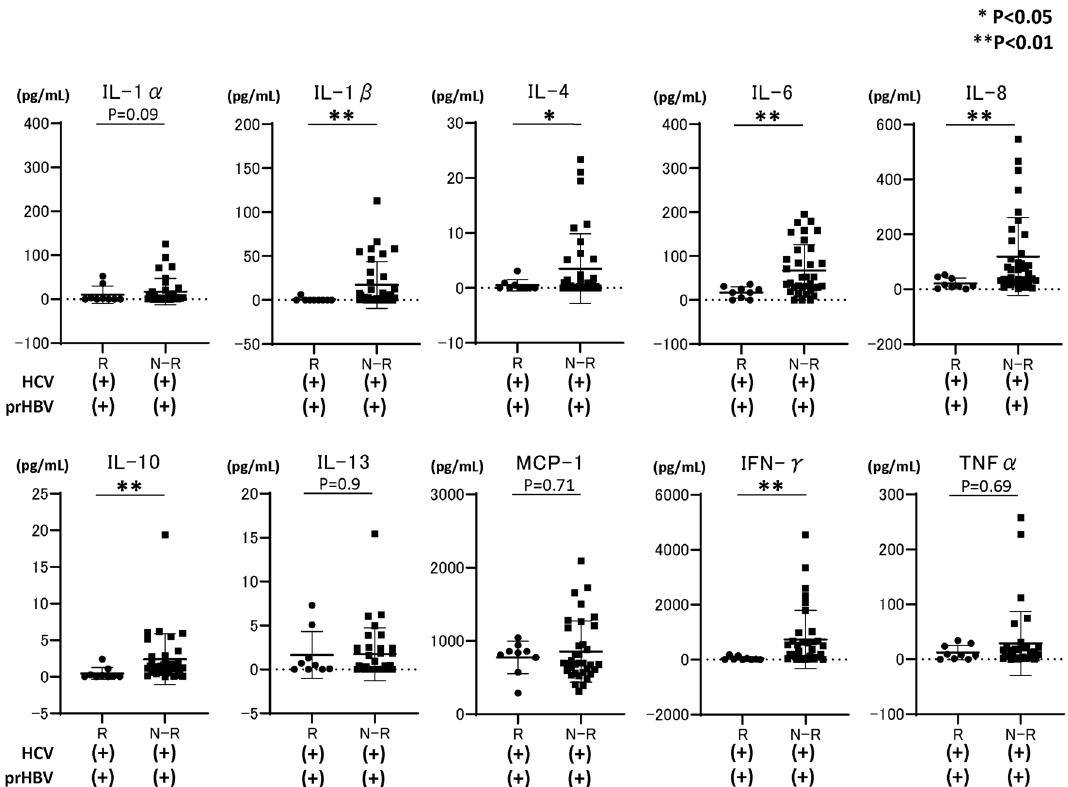
Figure 2. Comparison of cytokine levels at the end of DAA treatment among HCV-infected patients without previous HBV infection, those with or without HBV reactivation during DAA therapy, and HCV-infected patients without previous HBV infection. Each data are shown as median ± SD. *P < 0.05, **P < 0.01. HCV hepatitis C virus, HBV hepatitis B virus, DAA direct-acting antiviral, IL interleukin, MCP monocyte chemotactic